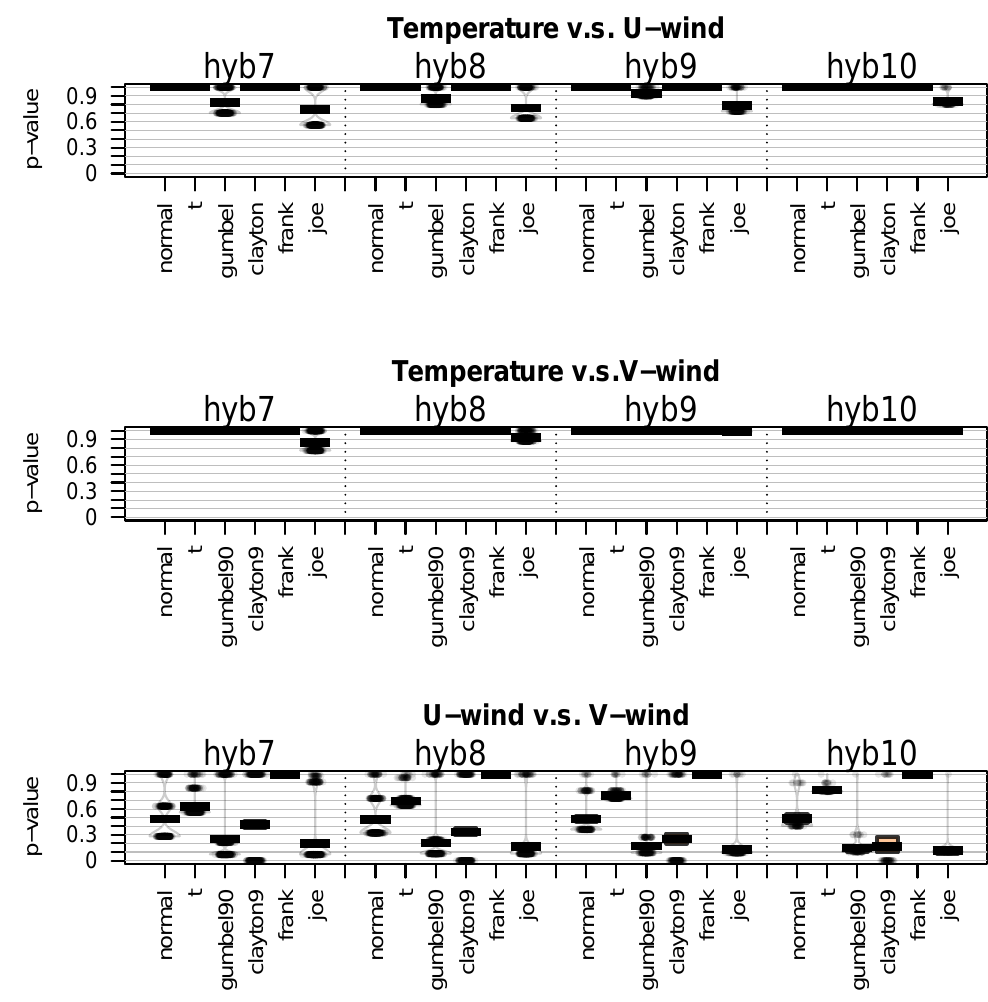
Figure 23. Hybrid Goodness-of-fit p values of the Gaussian, t , Gumbel, Clayton, Frank, and Joe copula families. A p -value close to zero will reject the copula family